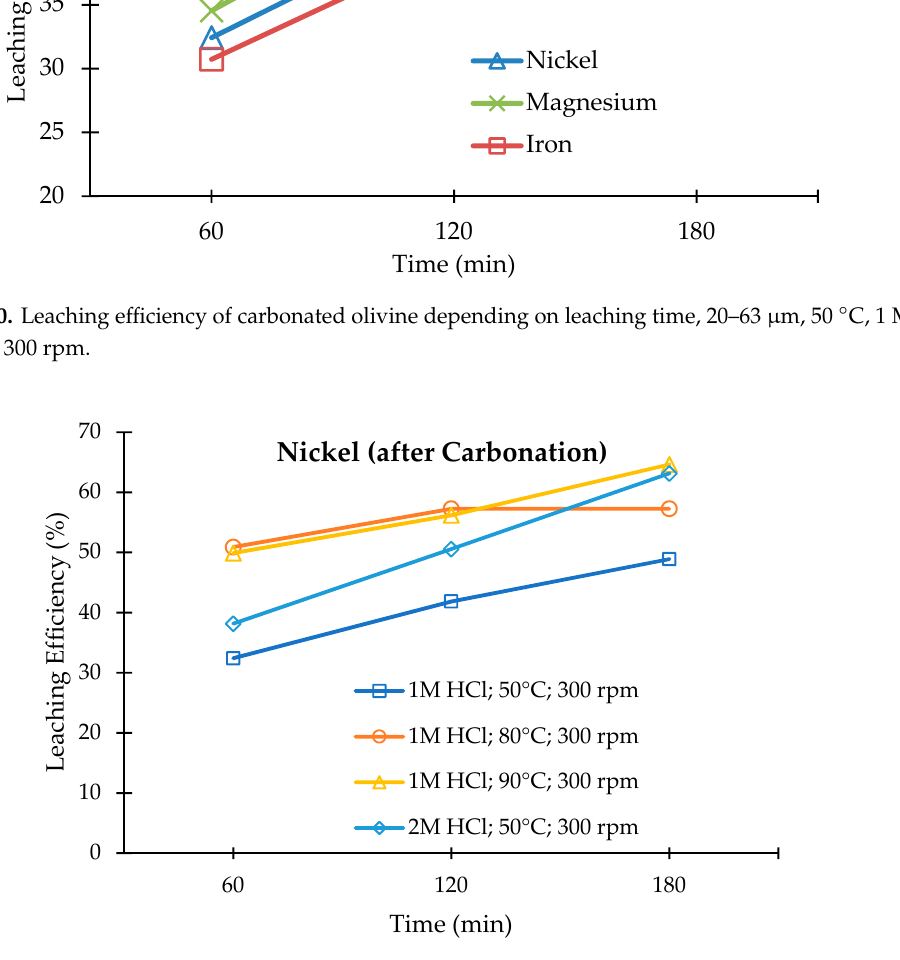
Figure 10. Leaching efficiency of carbonated olivine depending on leaching time, 20–63 µm, 50 °C, 1 M HCl and 300 rpm.